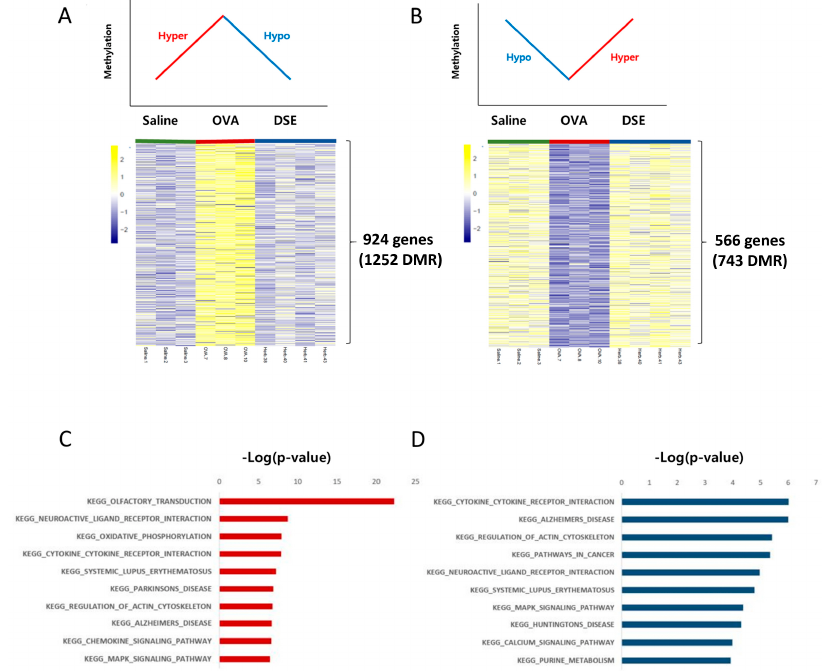
Figure 3. Anti-asthmatic methylation patterns in response to DSE treatment. Heat map of hyper/hypo methylated genes in OVA vs. saline and DSE vs. OVA ( A ). Heat map of hypo/hyper methylated genes under the same conditions ( B ). Top 10 functional annotation results of hyper/hypo methylation pattern, consisting of 924 genes (1252 DMRs) ( C ), and hypo/hyper methylation pattern, containing 566 genes (743 DMRs) ( D ). KEGG pathway names are shown on the left, and the bars on the right represent the − log ( p -value) of the corresponding pathway.